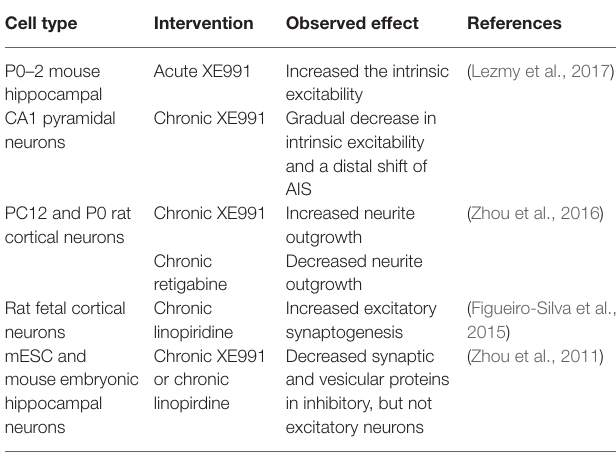
TABLE 1 | Overview of in vitro studies that use pharmacological blockers or openers to chronically block the